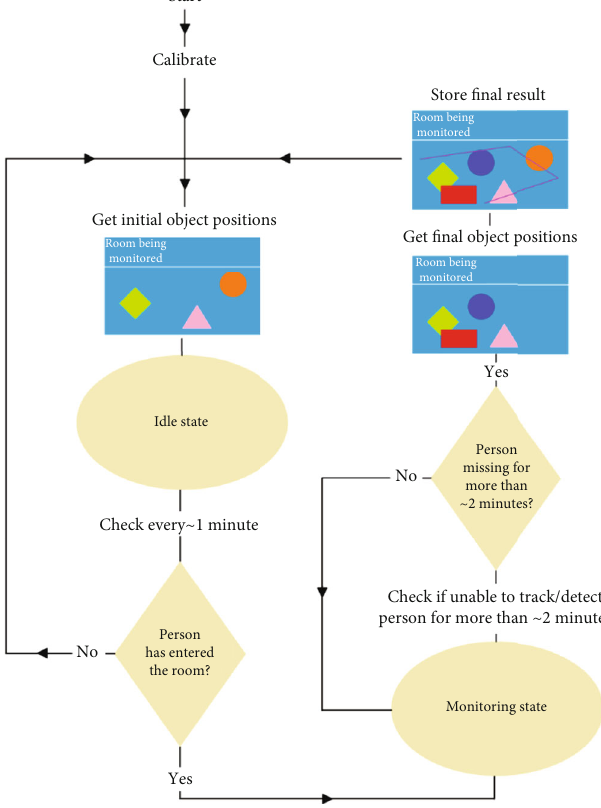
Figure 4: Flow diagram of the proposed passive monitoring